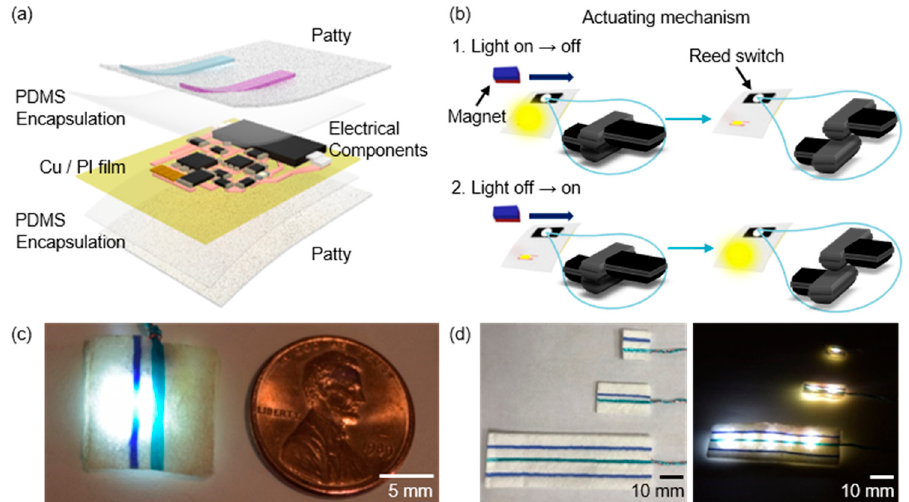
Figure 1. System overview of a surgical lighting patty. ( a ) Schematic illustration of a surgical lighting patty and ( b ) procedures for actuating mechanisms. ( c ) Image of a surgical lighting patty, next to a US penny coin. The surgical lighting patty is 1 mm thick, 12.7 mm wide, and 12.7 mm long. ( d ) Different sizes of surgical lighting patties (0.5” × 0.5”, 0.5” × 1”, and 1” × 3”; top to bottom, respectively) (left) and wireless operation (right).